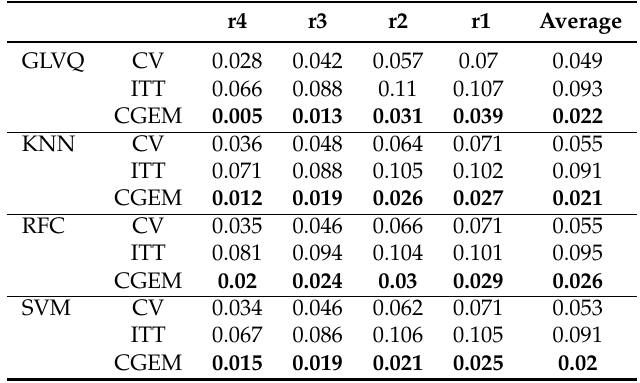
Table 2. Accuracy Estimation Errors ( AEE ) of tested classifiers on Four Gaussians data sets. r4